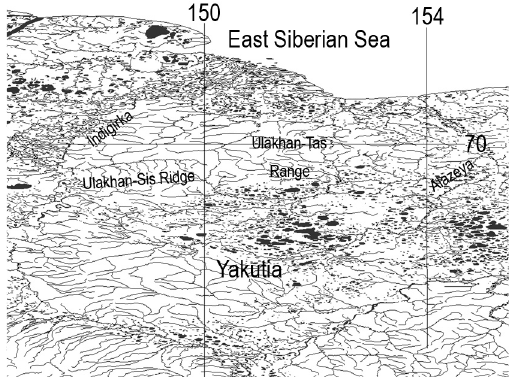
Fig. 21. Map of Upper Elovka River calving grounds.